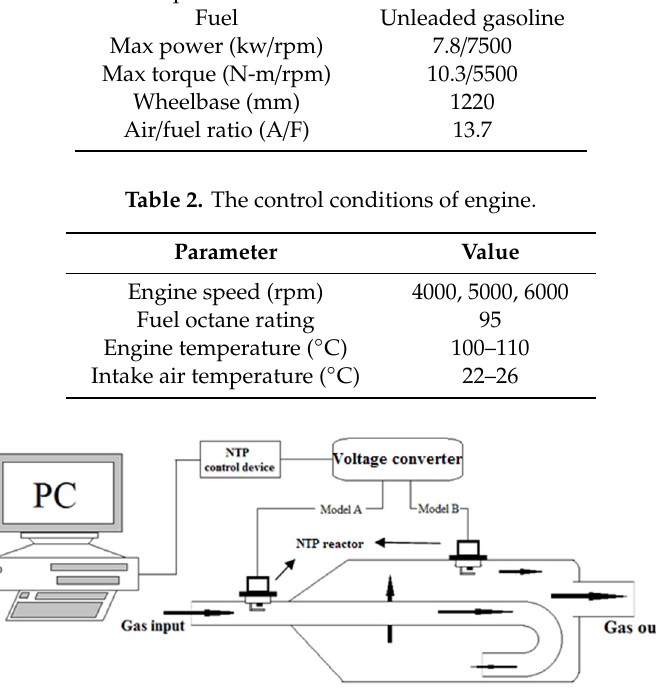
Figure 2. The setup of non-thermal plasma (NTP) system.